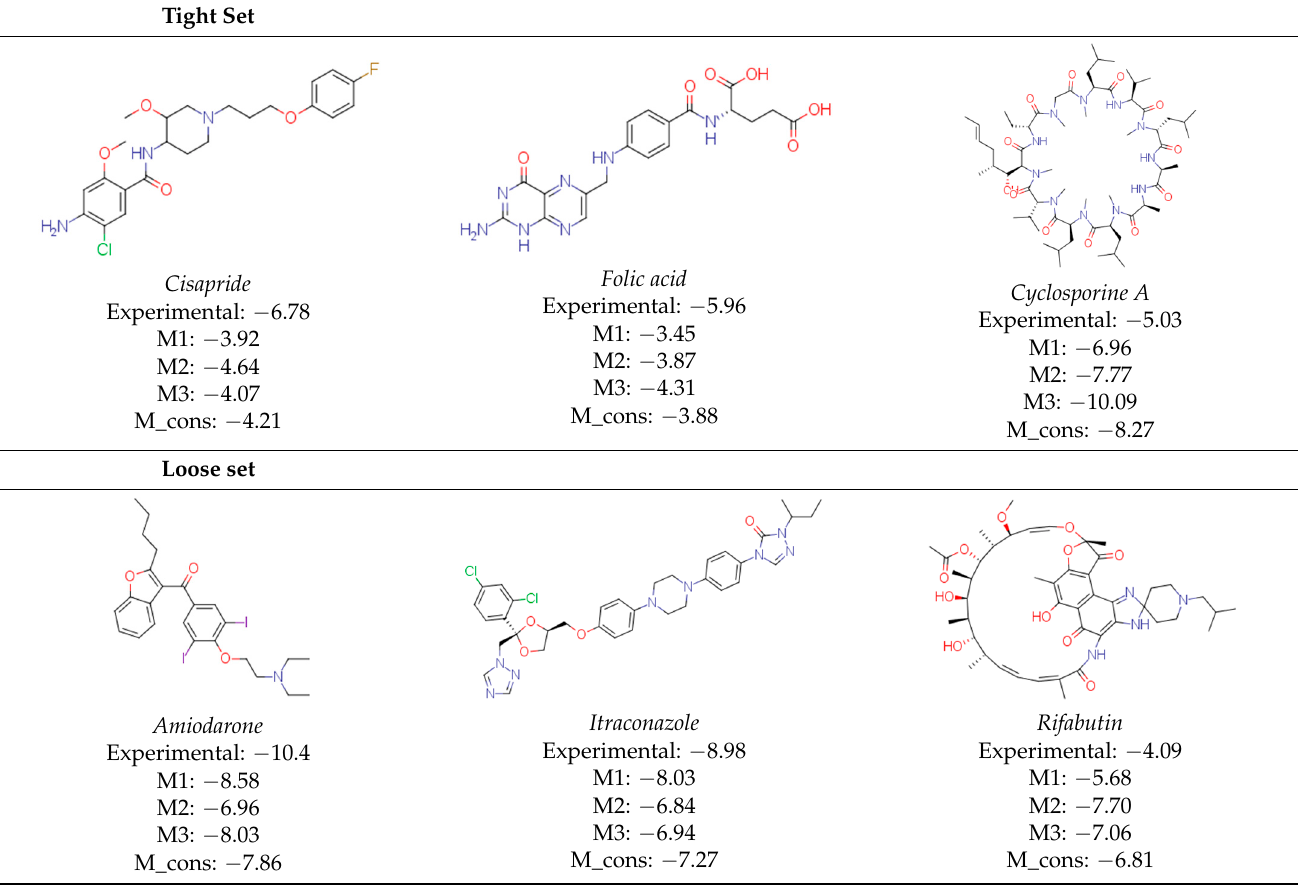
individual models (Table 2: M_cons, https://doi.org/10.15152/QDB.257, accessed